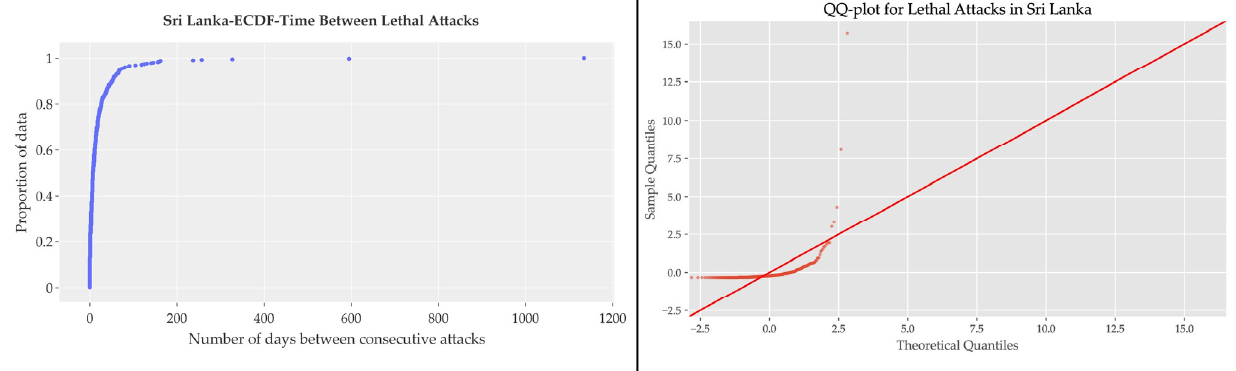
Figure 18. The time between consecutive lethal attacks and the corresponding QQ plot for Sri Lanka.